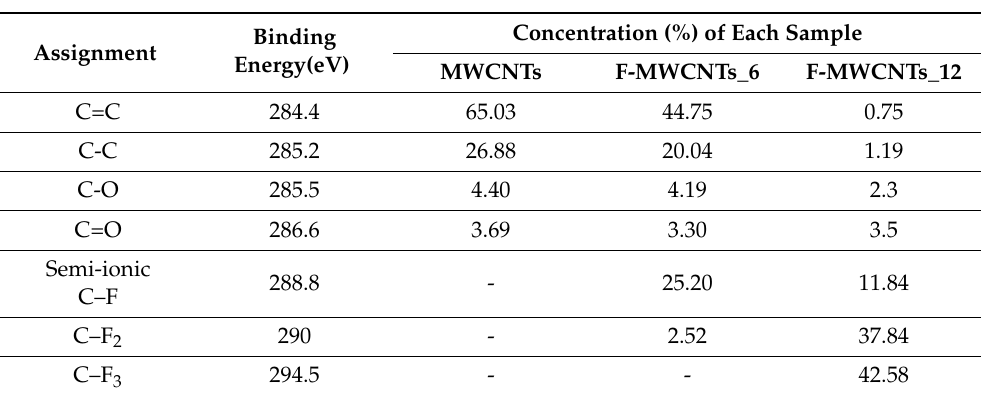
Table 2. Peak parameters for the C 1s components of MWCNTs, F-MWCNTs_6 and